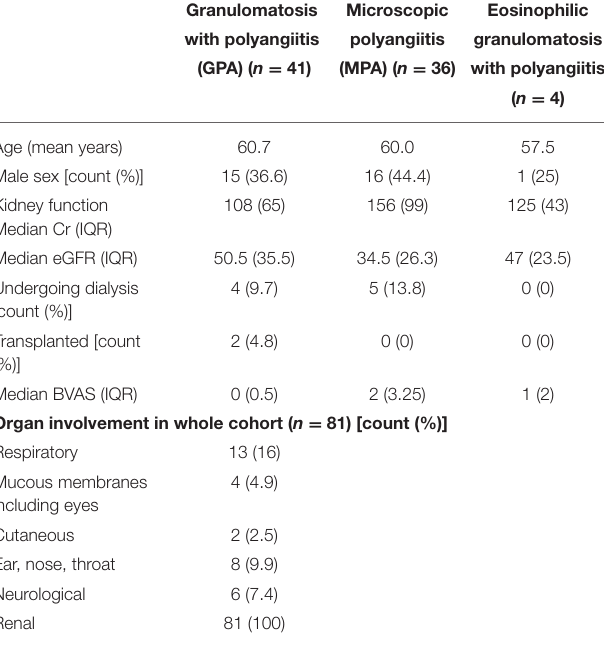
TABLE 1 | Patient characteristics at